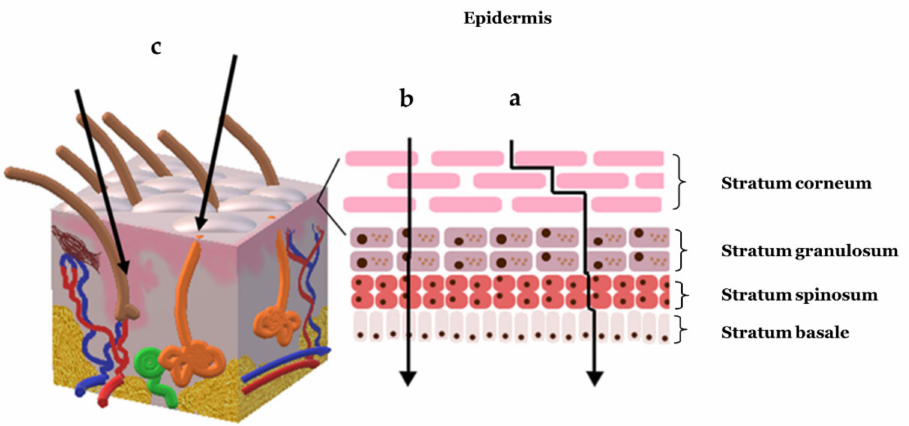
Figure 1. Skin layer structure and penetration routes: ( a ) intercellular ( b ) transcellular ( c ) transap- pendageal